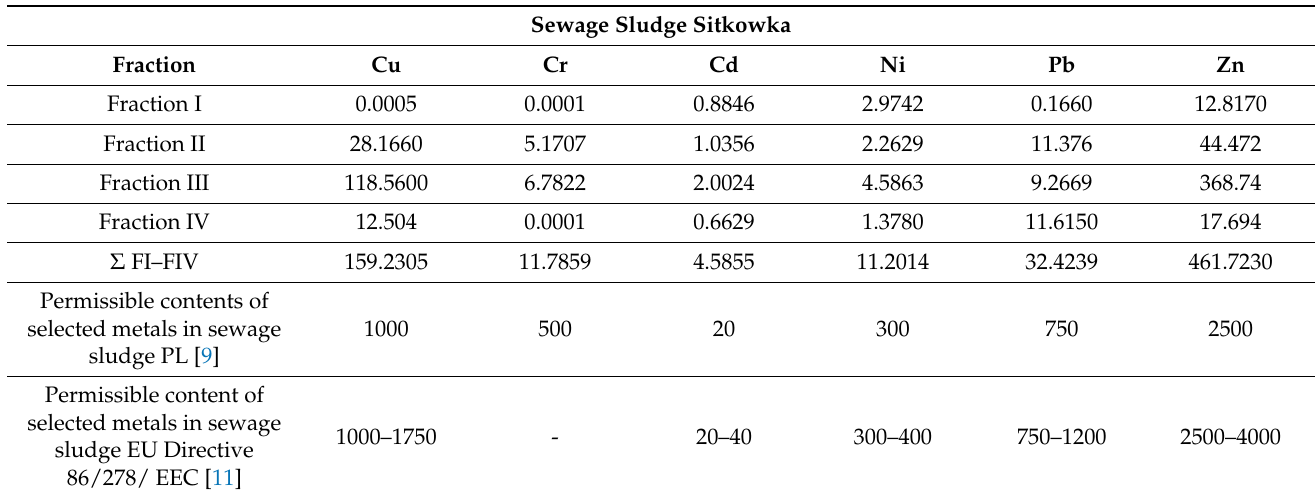
Table 6. Chemical speciation of heavy metals in sewage sludge from the Sitkowka wastewater treatment plant in the Swietokrzyskie Voivodship (mg/kg).